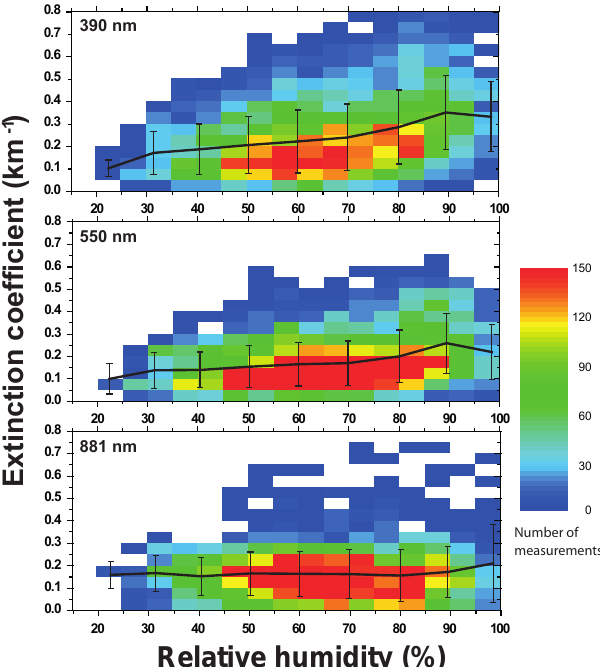
Figure 2. Measured particle extinction coefficients for the wave- lengths of 390nm (top), 550nm (center) and 881nm (bottom) as a function of relative humidity. The color scale indicates how fre- quently a given extinction coefficient was measured during the 2009–2012 period. Mean values (bold lines) of extinction coeffi- cients and corresponding standard deviation (SD, vertical bars) are shown for 10% humidity